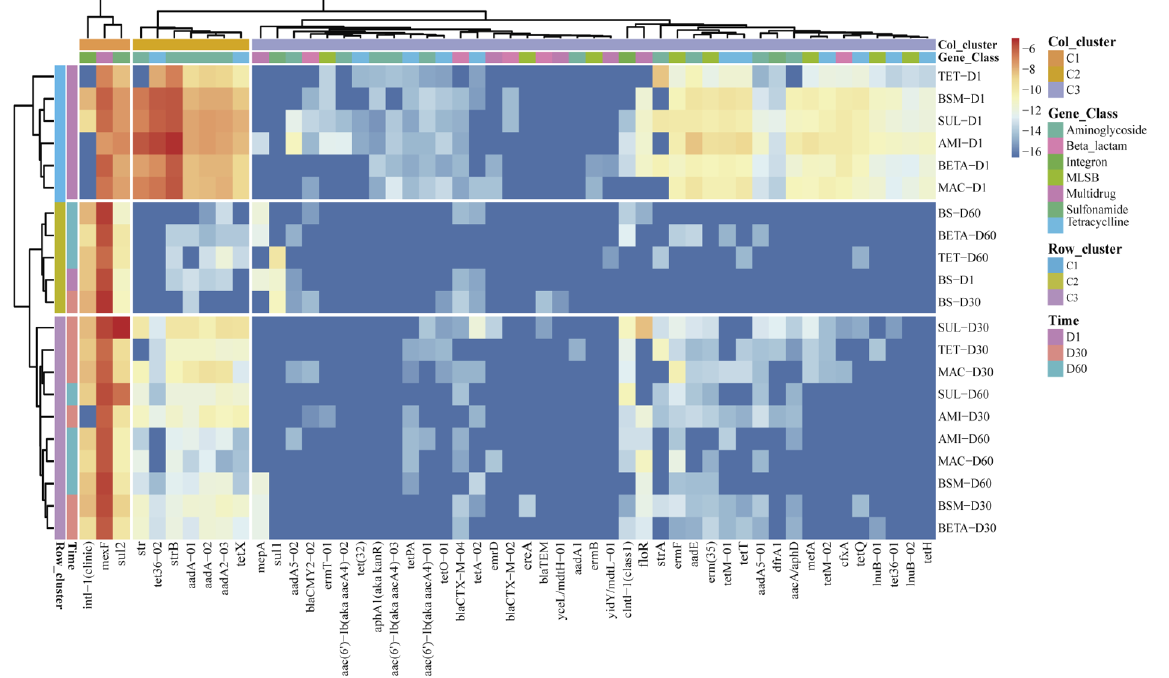
Figure 3. Heatmap of ARGs (coverage, copies per 16s rRNA gene, log 2 transferred) of soil samples. Hierarchical clustering was based on Euclidean distance with the clustering method “complete”.